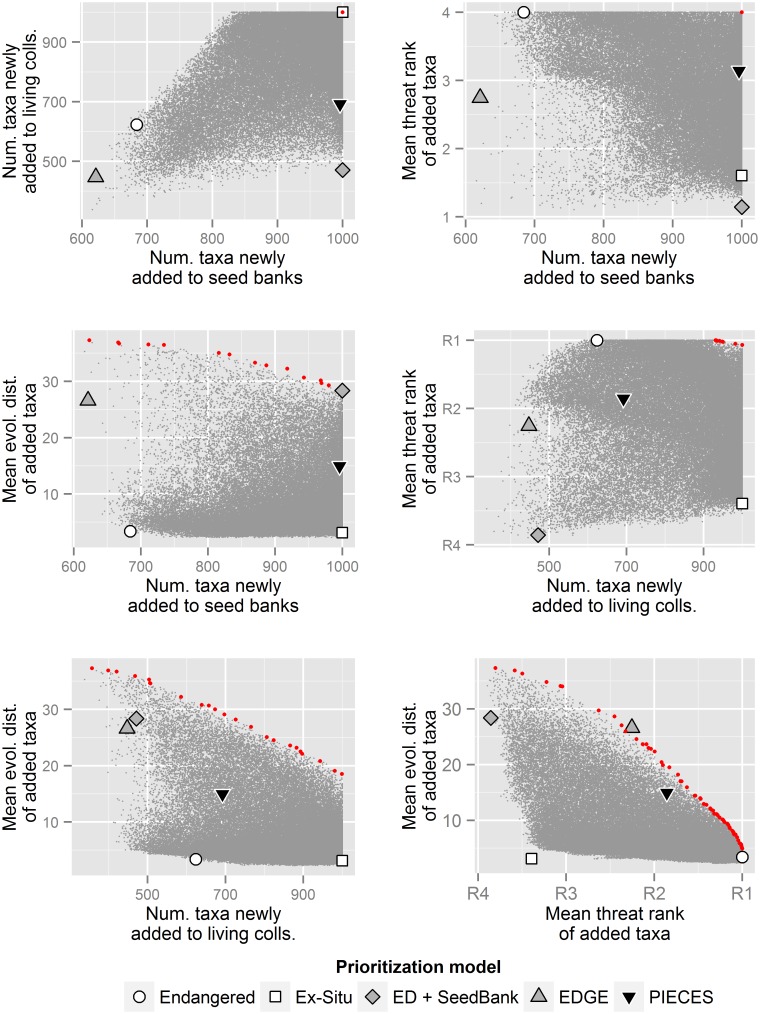
Return on investment (ROI) and tradeoffs among different objectives associated with ex situ conservation of 1,000 taxa selected using alternative prioritization schemes.Clouds of small gray points depict potential ROI; these were derived using weight space analysis (see Materials and Methods). Red symbols highlight the Pareto frontier: values for each objective such that one objective cannot be improved without the paired objective being deteriorated. Points indicate results for five different approaches to prioritization, with ROI as follows: Number of taxa newly added to seed banks: Endangered = 684; Ex Situ = 1,000; ED + Seedbank = 1,000; EDGE = 621; PIECES = 996. Number of taxa newly added to living collections: Endangered = 624; Ex Situ = 1,000; ED + Seedbank = 471; EDGE = 447; PIECES = 692. Mean threat rank of added taxa (where 1 = R4 [apparently secure], 4 = R1 [critically imperiled]): Endangered = 4; Ex Situ = 1.6; ED + Seedbank = 1.1; EDGE = 2.7; PIECES = 3.1. Mean evolutionary distinctiveness of added taxa: Endangered = 3.4; Ex Situ = 3.1; ED + Seedbank = 28.4; EDGE = 26.6; PIECES = 14.9.